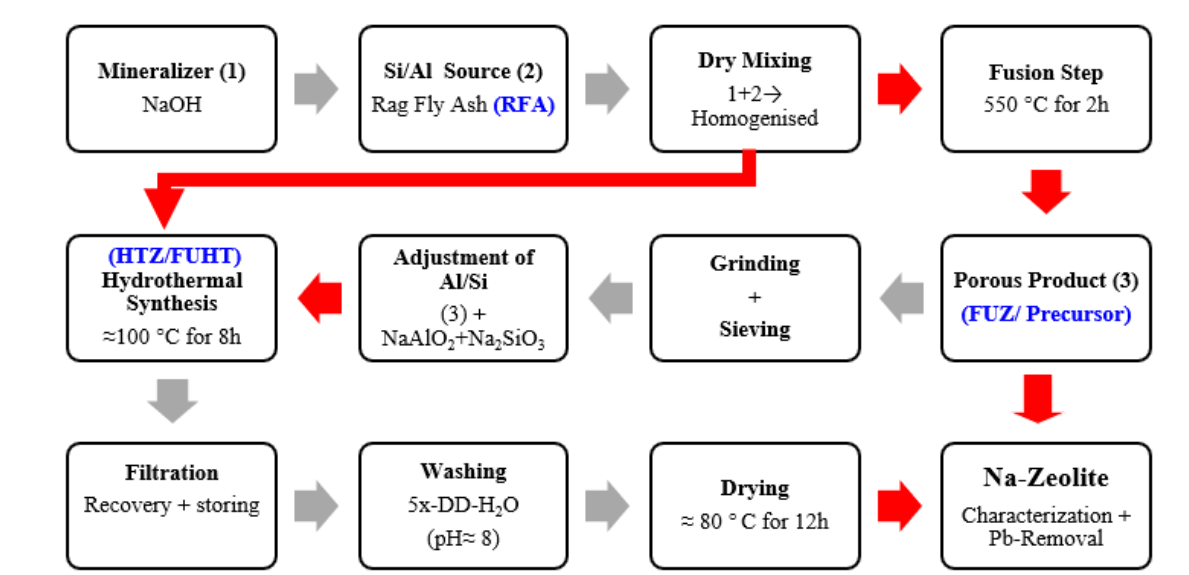
Figure 1. Flowsheet diagram for NaOH-activated hydrothermal (HTZ), fusion (FUZ), and fusion-assisted hydrothermal (FUHT) synthesis of Na-zeolites from rag fly ash (RFA).